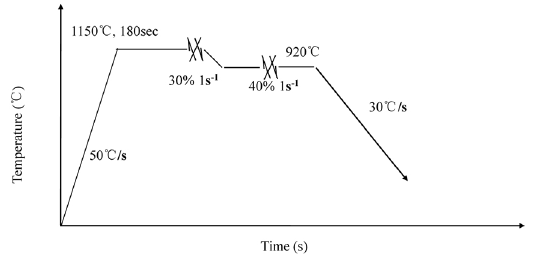
Figure 1. Schematic illustration of measuring A r